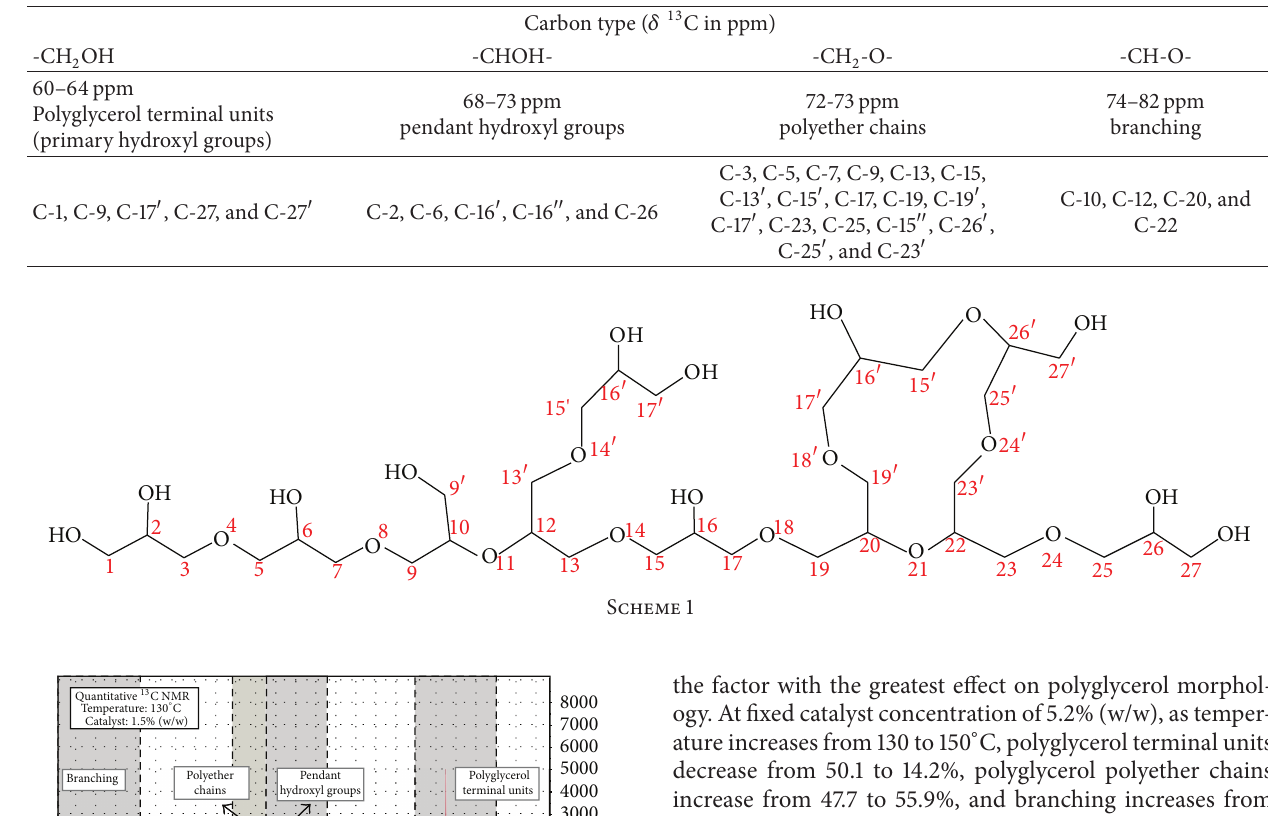
Table 4: Model of glycerol polymerization growing chain containing linear, branched, and cyclic segments and their carbons assignments by 13 C NMR (see also Scheme 1) [12, 14, 17].